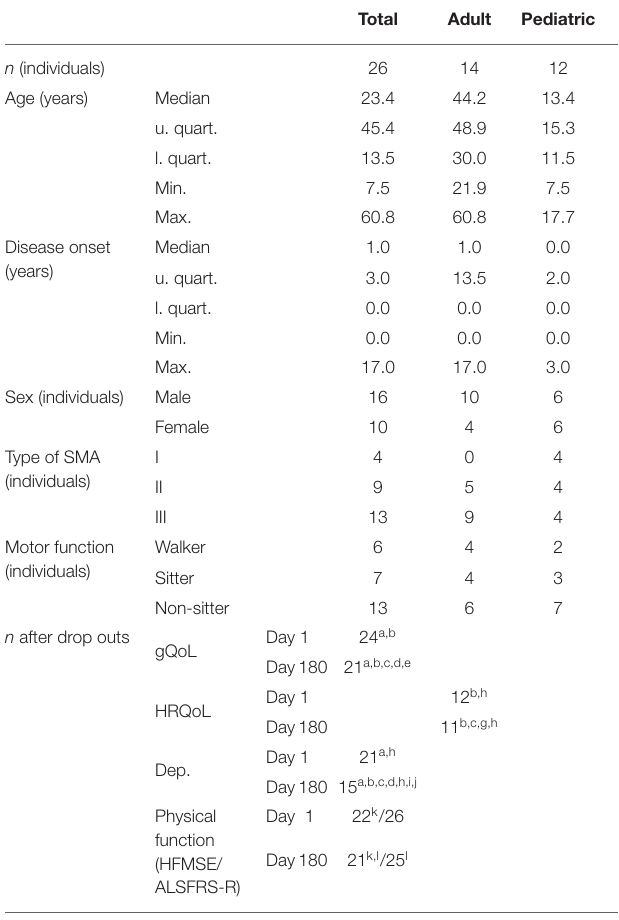
TABLE 1 | Demographics and clinical